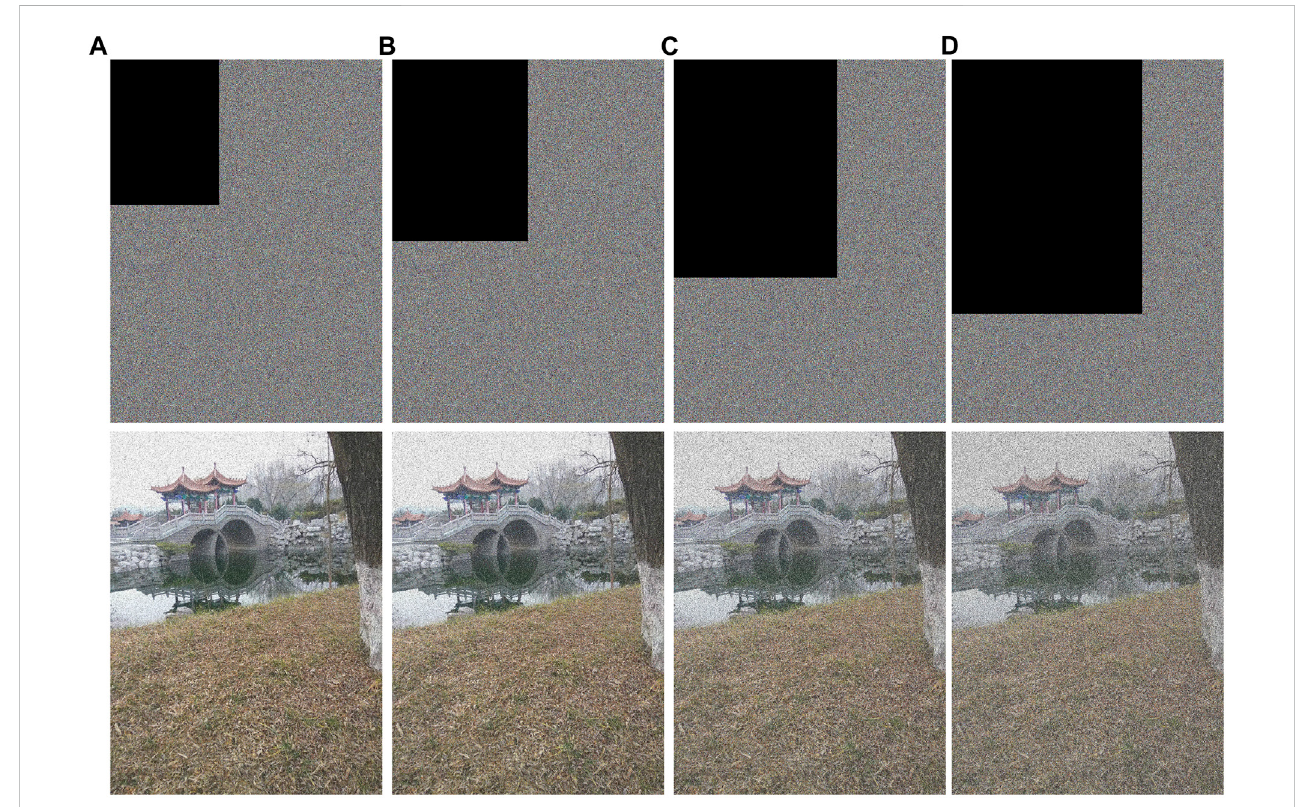
FIGURE 8 Occluded attack: (A) is the result of an experiment that occluded 16% of encrypted images, (B) is the result of an experiment that occluded 25% of encrypted images, (C) is the result of an experiment that occluded 36% of encrypted images, and (D) is the result of an experiment that occluded 49% of encrypted